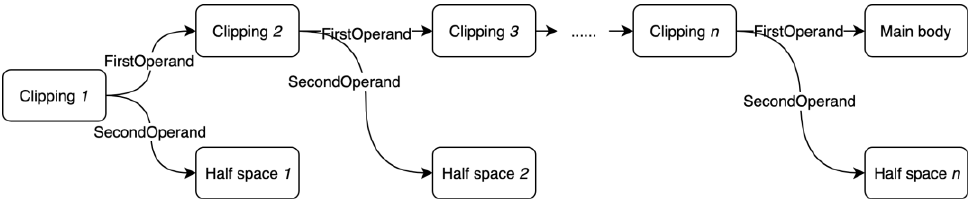
Figure 3. Structure of multi-clipping, i.e., the clipping chain.